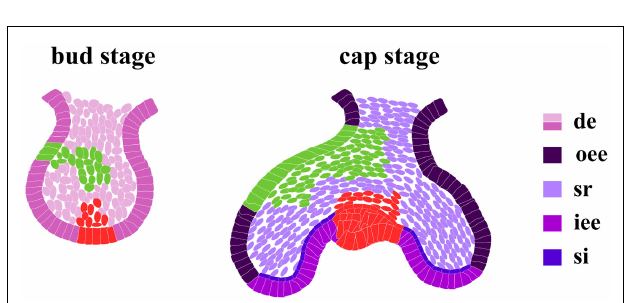
FIGURE 4 | Hierarchical model for stem cell commitment during development of various ectodermal organs. Skin and oral epithelia arise from the surface ectoderm. Putative multipotent stem cells residing in both epithelia can take different fate decisions, giving rise to diverse appendages. During further development of ectodermal organs, more committed tissue-specific stem cells arise from these putative multipotent stem cells in the skin and oral epithelium. Subsequently, tissue-specific stem cells give rise to progenitors or transient amplifying cells that differentiate into functional cell